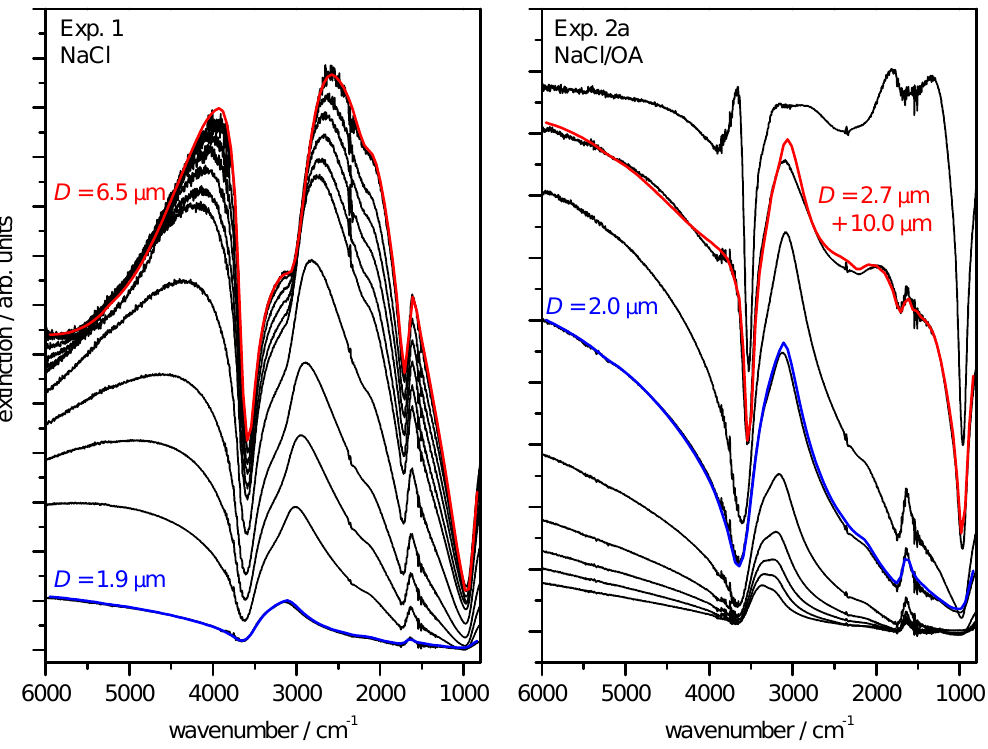
Fig. 8. Series of infrared extinction spectra recorded during the first expansion cooling cycles of Exp. 1 and Exp. 2a (black lines). The spectra are to be read from bottom to top and were recorded at a 10s time interval during t =70–200s (Exp. 1) and t =30–110s (Exp. 2a), as indicated by horizontal grey bars on the time scales of the OPC2 scatter plots in Fig. 5. Various computed extinction spectra that best-fitted the measurements are shown as red and blue lines. Both coloured lines in the left panel as well as the blue trace in the right panel represent fits by unimodal log-normal number size distributions of supercooled water, yielding the indicated count median diameters D . The red line in the right panel represents a bimodal fit by two log-normal modes, with one mode for water droplets and the other for ice crystals. The latter were modelled as circular cylinders of aspect ratio 0.7 (Wagner et al.,